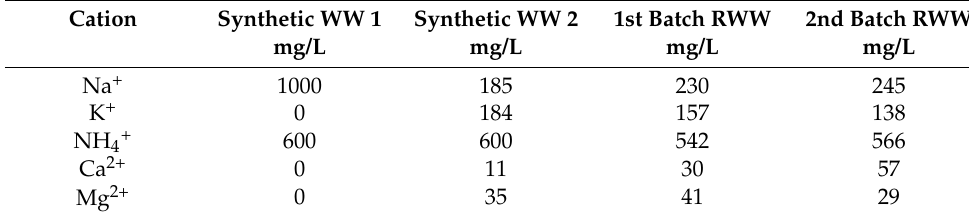
Table 2. Relevant concentrations of cations in the solution used in the 2nd part of the